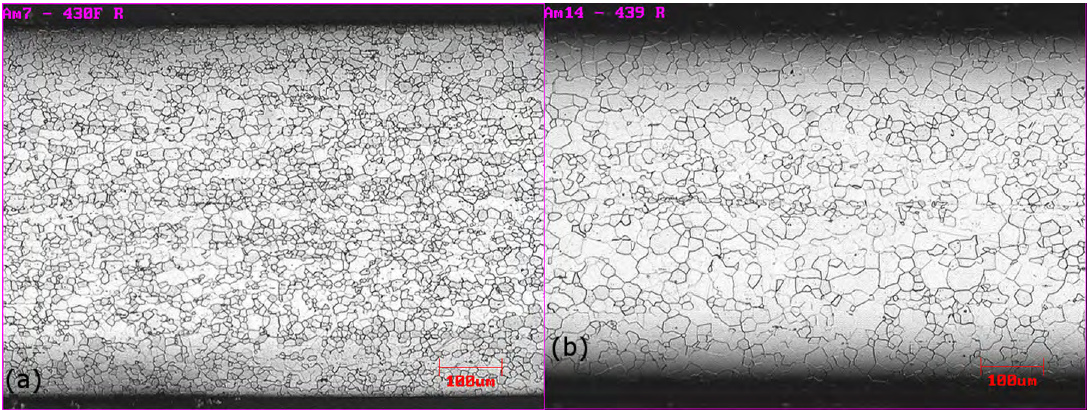
Figure 4. Microstructure of the samples after annealing treatment (a) 430Nb A (b) ASTM 439 A. atoms in 430Nb steel promoted a faster recrystallization under lower temperatures, since solid solution atoms tend to migrate to grain boundaries decreasing either nucleation and growing rates.